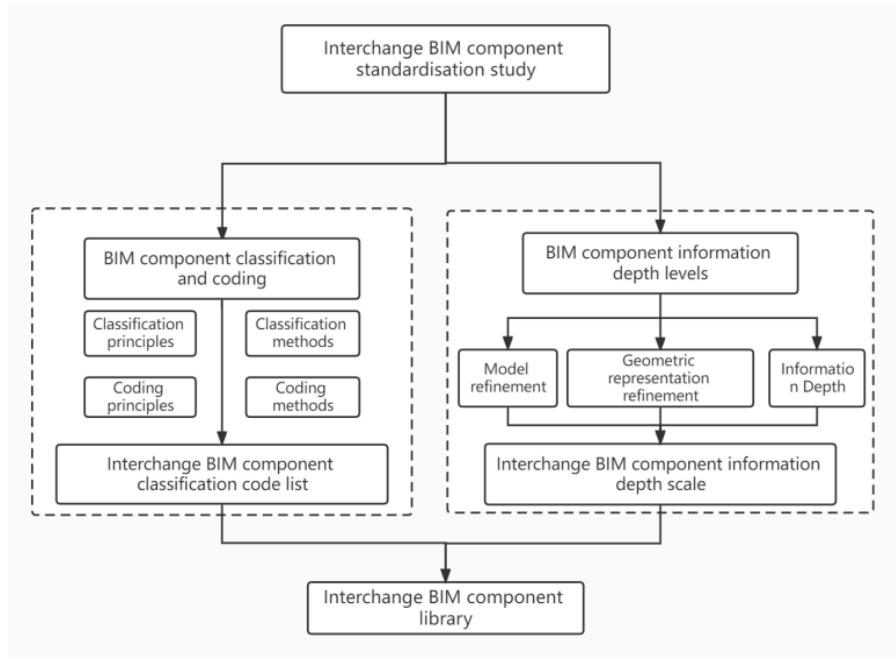
Figure 1. The process of interchange BIM components